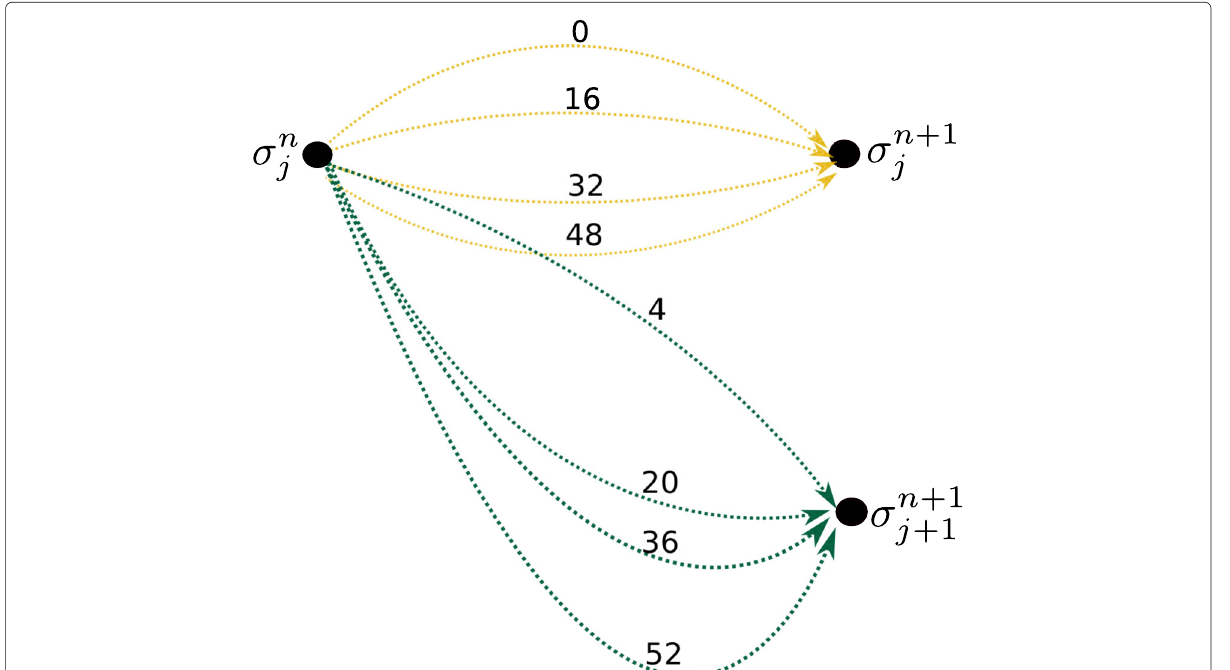
Fig. 11 Example of parallel transitions for Viterbi decoder of trellis shaping at the transmitter, according to mapping of the Fig.